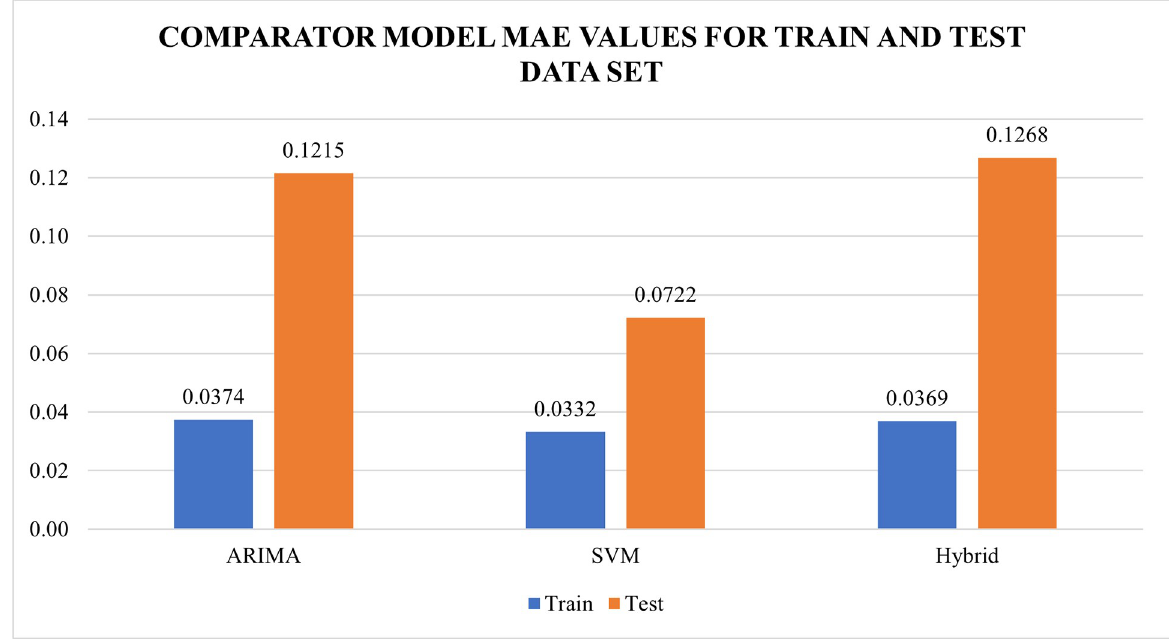
Fig 4. MAE values for both test and training dataset for ARIMA model, SVR model and ARIMA-SVR hybrid model.